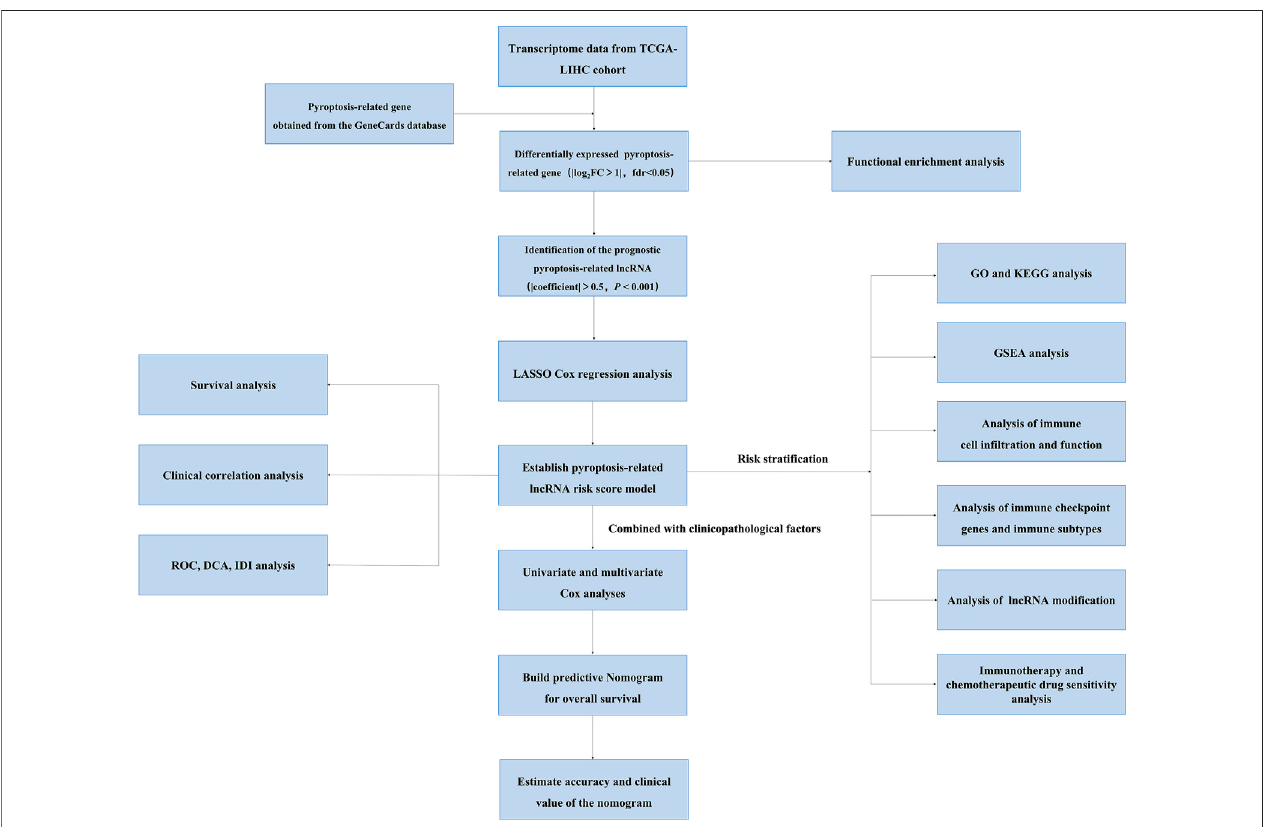
FIGURE 1 | The fl owchart of this study showing the process of constructing the 12 pyroptosis-related lncRNA risk score to predict prognosis of HCC.